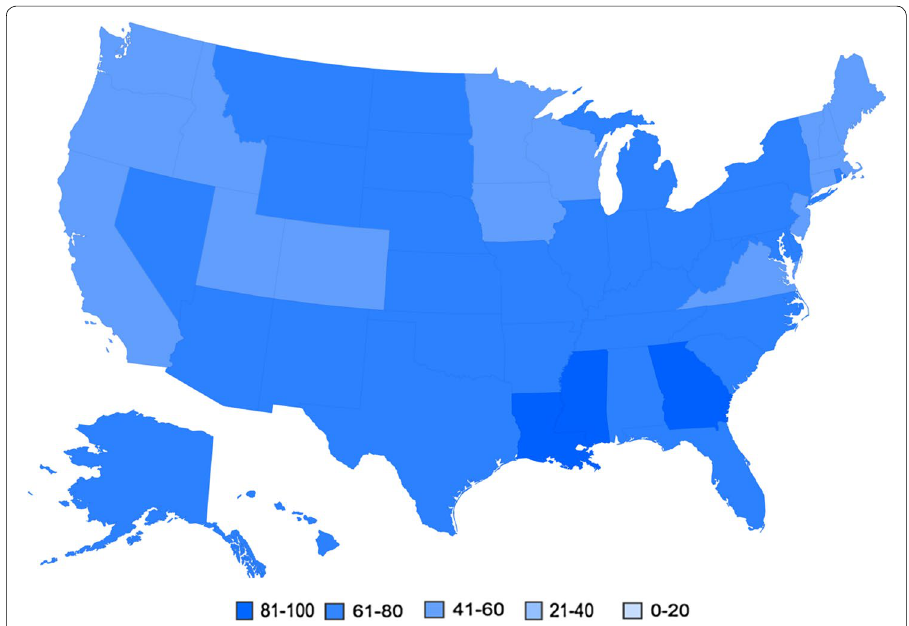
Fig. 1 Heat map of the online interest in the term ‘Chlamydia’ by state